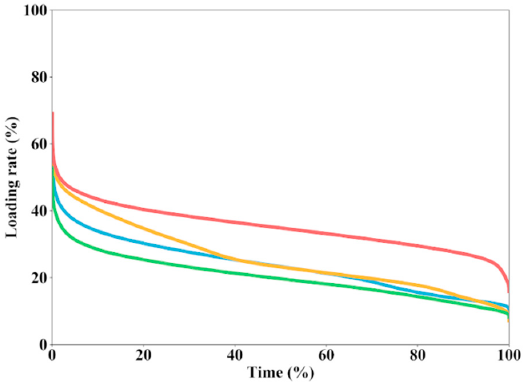
Figure 2. Load duration curves in power transformers in four secondary substations over a period of a year of Smartcity Malaga Living Lab.